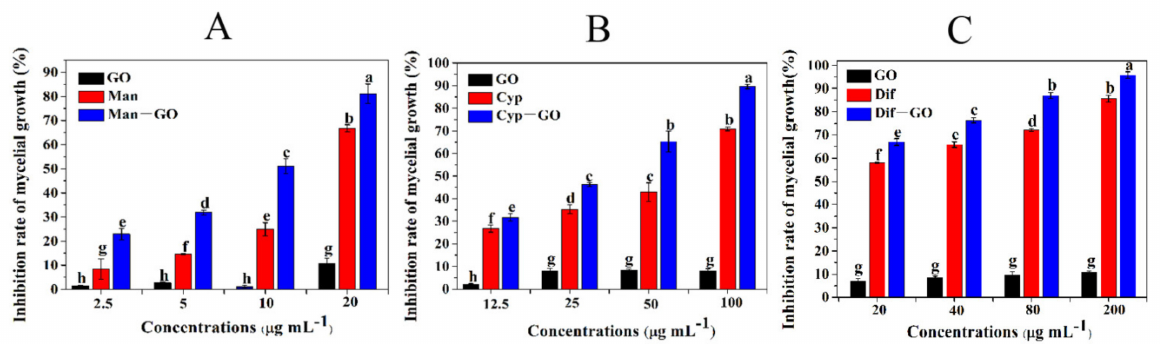
Figure 3. Inhibitory activities of GO, fungicides and GO–fungicides on the mycelial growth of F. graminearum . The inhibition rate of mycelial growth was tested at different concentrations of GO and Man–GO ( A ), Cyp–GO ( B ) and Dif–GO ( C ) for 120 h at 24 ± 2 ◦ C. Data are mean ± SE. Error bars represent the SE (N = 4). Different lowercase letters indicate significant differences between treatments ( p < 0.05).